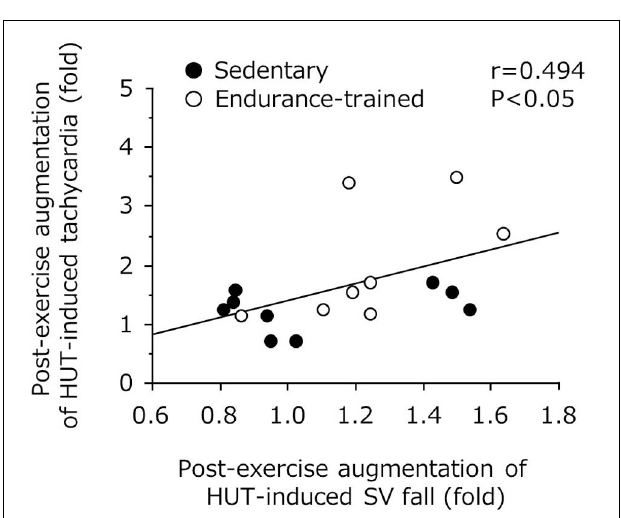
FIGURE 5 | Correlation between post-exercise augmentations of stroke volume (SV) fall and tachycardia with 5-min orthostatic